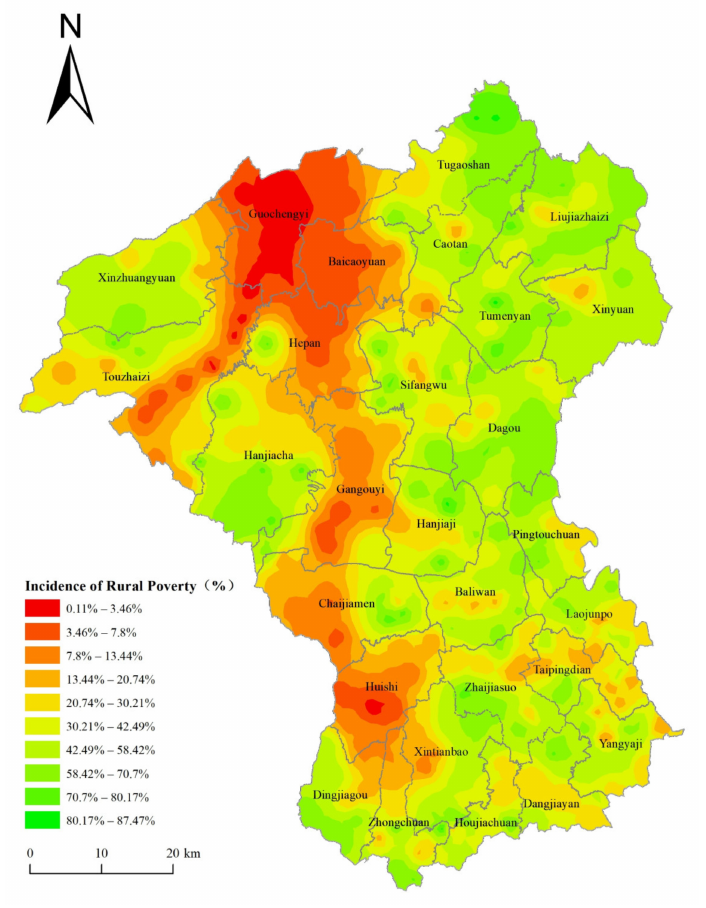
Figure 2. Spatial pattern of rural poverty rates in